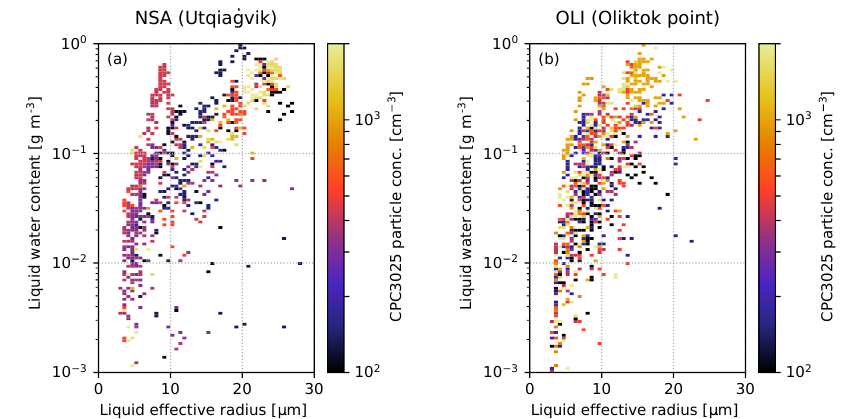
Figure 10. As Fig. 8, but with absolute values for CPC3025 condensation nuclei CN concentration.